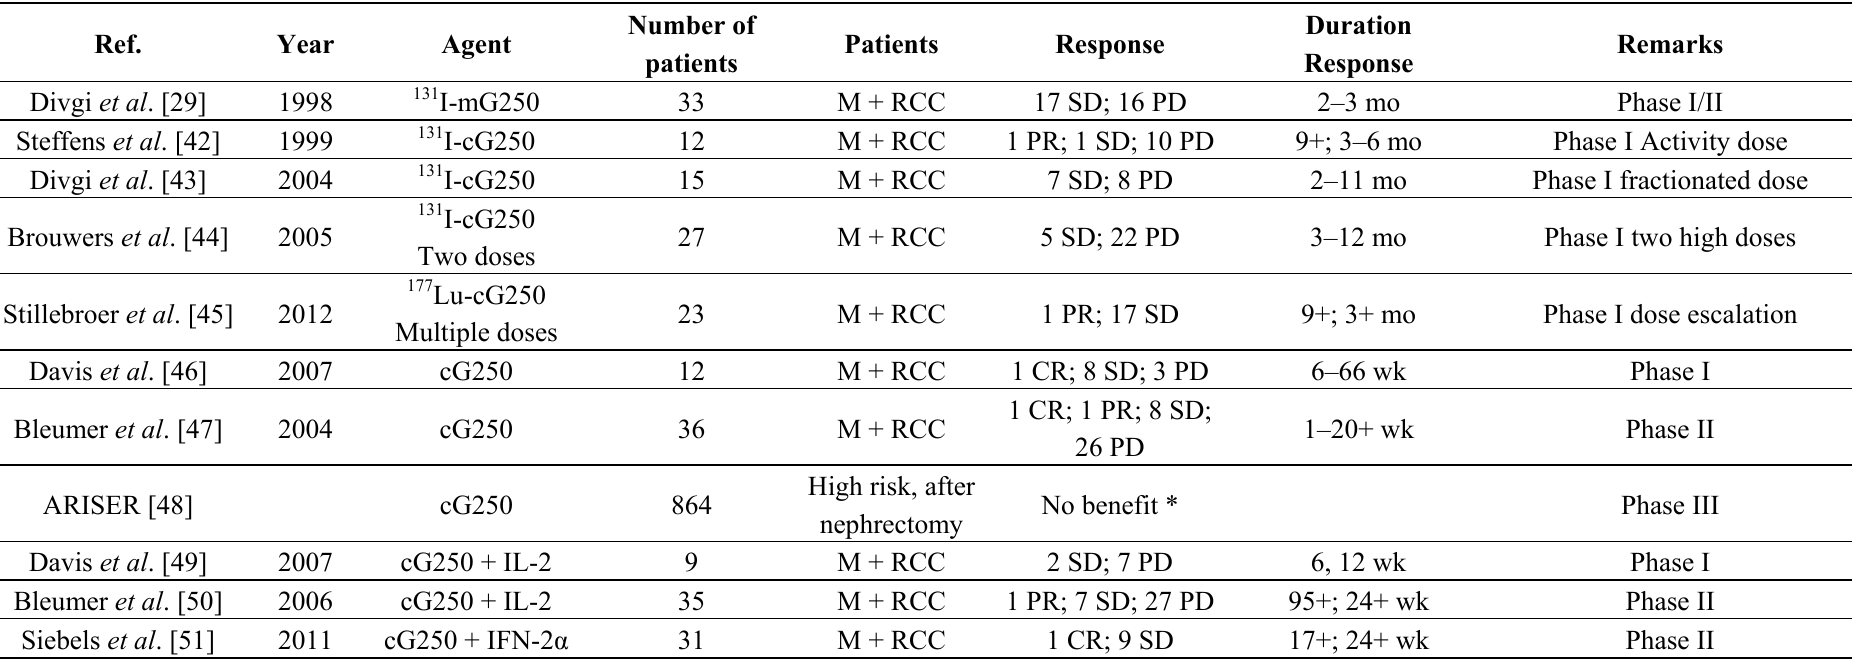
Table 2. Overview of Therapy studies with mAbG250 in RCC